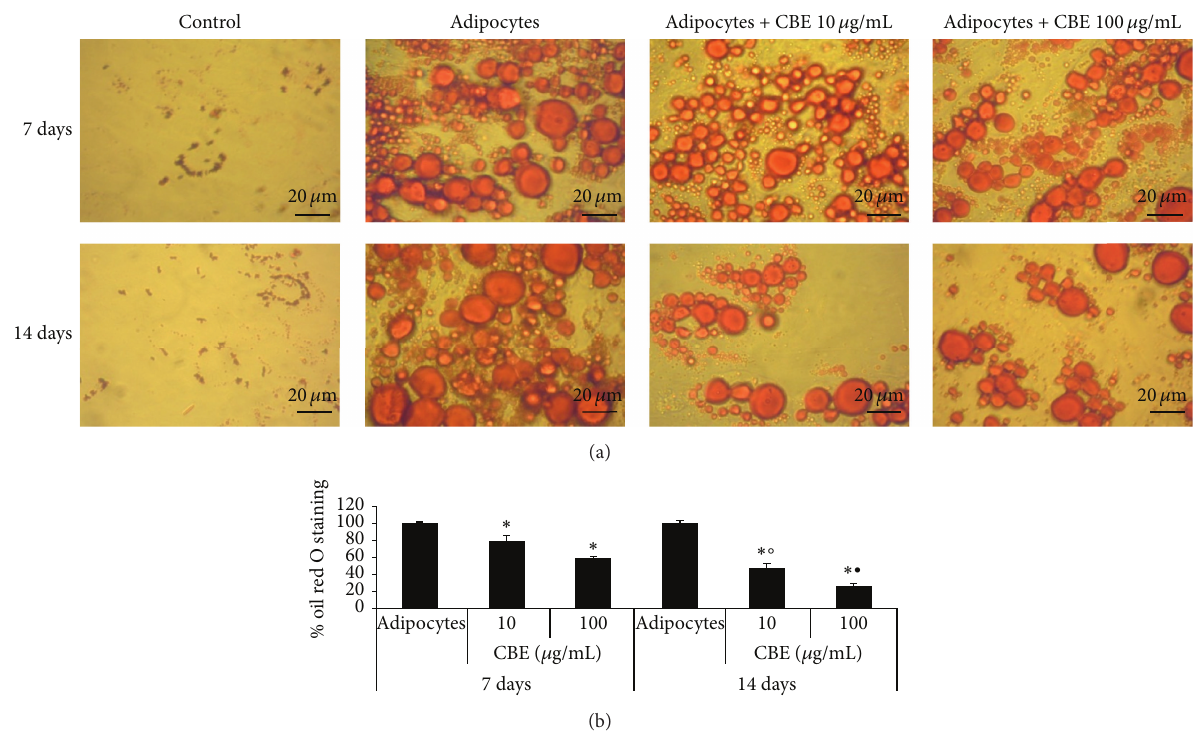
Figure 3: Effect of 10 and 100 𝜇 g/mL Citrus bergamia extract (CBE) on the lipid content of 14-day differentiated adipocytes stained with oil red O. (a) A representative photograph from three independent experiments of untreated mesenchymal stem cells (Control), 14-day differentiated cells (adipocytes), adipocytes with 10 or 100 𝜇 g/mL CBE at 7 and 14 days was shown. (b) The levels of oil red O incorporation was quantified by measuring the absorbance of isopropyl alcohol extract at 𝜆 = 550 nm. Data were shown relative to 14-day differentiated adipocytes and expressed as mean ± SD from three independent experiments. ∗ 𝑝 < 0.01 versus the 14-day differentiated adipocytes (100%) at same day; ∘ 𝑝 < 0.01 versus CBE 10 𝜇 g/mL at 7 days; ∙ 𝑝 < 0.01 versus CBE 100 𝜇 g/mL at 7